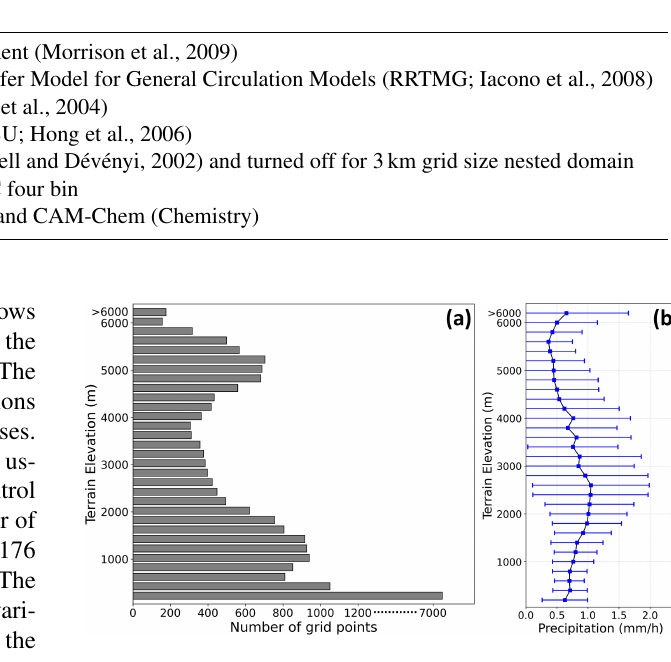
Figure 2. (a) The total number of grids per elevation range for 200m bins up to 6000m and one bin above 6000m. (b) Variation of CTL mean ( ± 1 standard deviation) precipitation over the CenHim as a function of